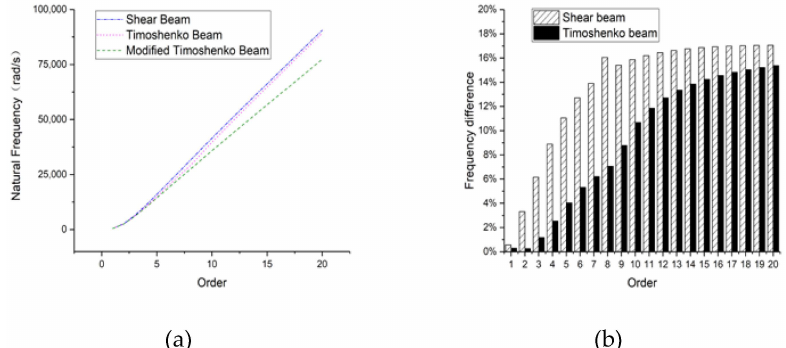
Figure 29. Natural frequencies of the 4-m-long beam: ( a ) overall frequency curve and ( b ) frequency di ff erence compared with a modified Timoshenko beam.